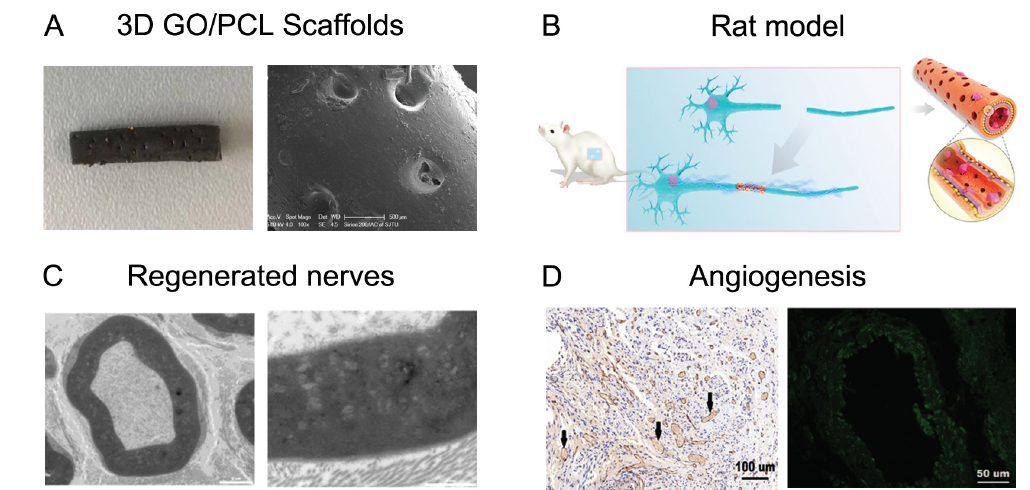
Figure 2. Examples of 3D-GO. (A) Optical (left) and scanning electron microscopic (right) images of GO/PCL scaffold showing the porous structure. (B) Nerve guidance conduits implantation in the rat model and a 3D GO/PCL tubular mold scheme. (C) Transmission electron microscopy images of regenerated nerves (scale left = 2 μm and right = 1 μm) in a GO/PCL conduit. (D) Study of angiogenesis in regenerated nerves by immunohistochemistry (left) of endothelial cells (black arrows) and immunofluorescence (right) staining of an associated vascular tissue protein in a GO/PCL scaffold after 18 weeks post injury (scale bars, black = 100 μm and white = 50 μm). Modified from Qian et al., 2018